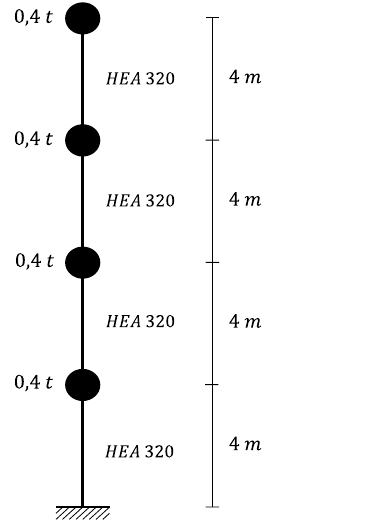
Figure 1. Structure of the 4-dof system.